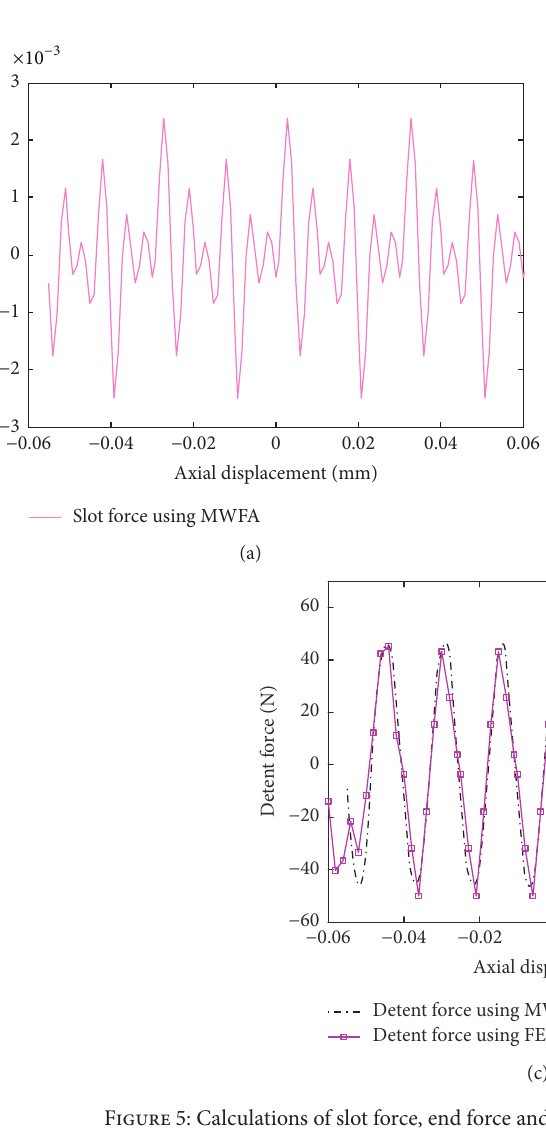
Figure 5: Calculations of slot force, end force and detent force distribution versus mover